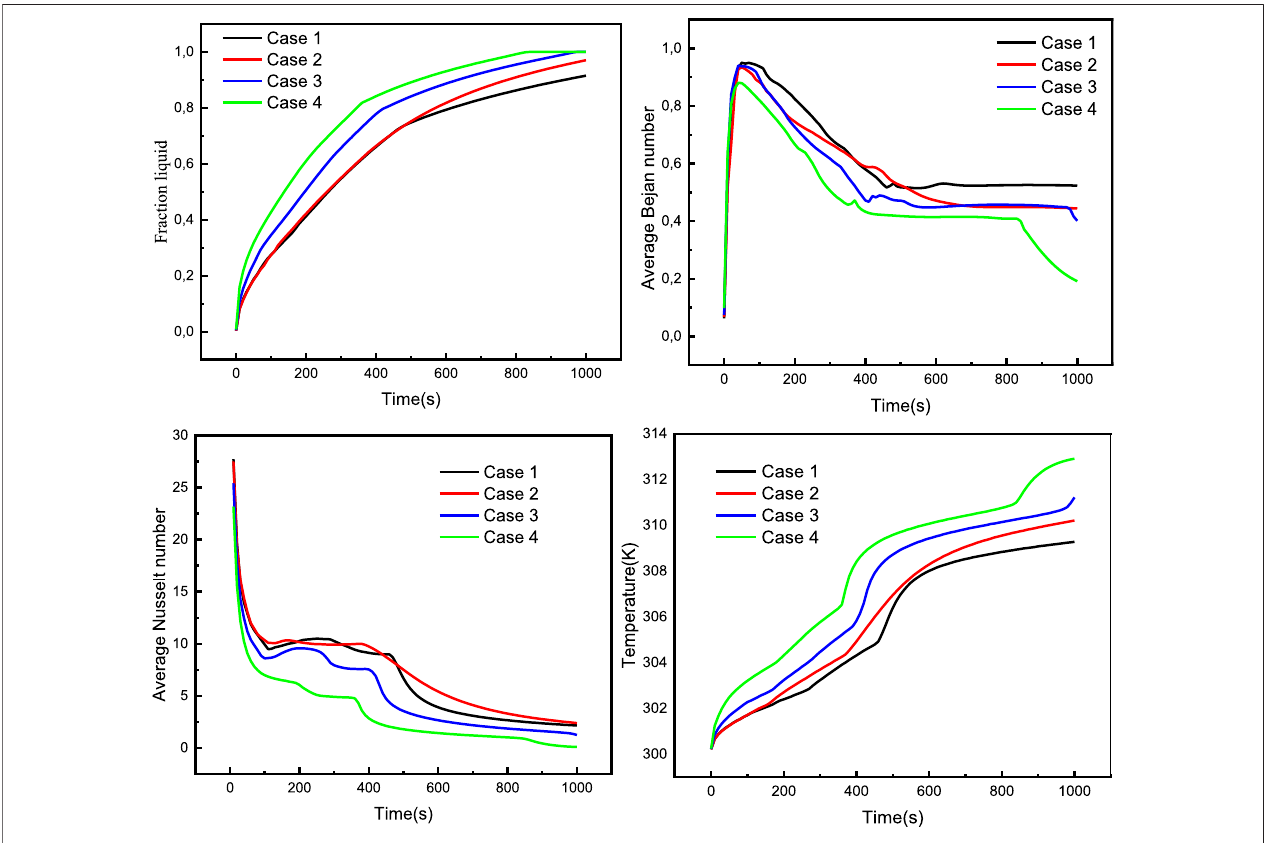
FIGURE 7 | The impact of fi ns number on liquid fraction, Average Bejan number, Average Nusselt number, and temperature distribution.